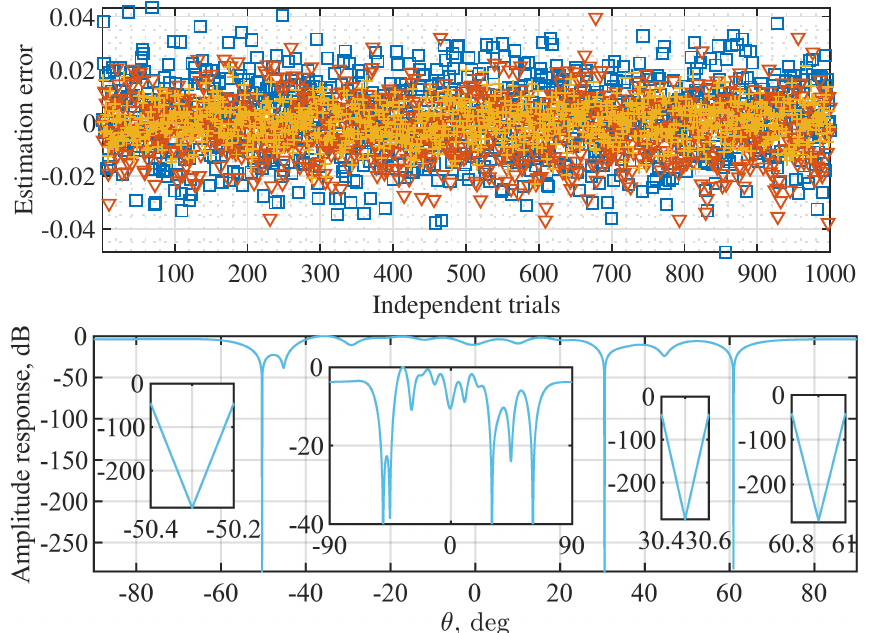
Figure 9. Illustration of the amplitude responses of AINB beams designed by Algorithm 1, where = 0, and the angles set in Figure 2 are used. The upper figure plots the N = 16, P = 3, K = 50, σ 2 i AoA estimation errors over 10 3 independent trials, where plus, triangle, and square markers are for 30.5 ◦ , 60.9 ◦ , and − 50.3 ◦ , respectively. Note that the second inset from the left in the lower sub-figure is the copy of Figure 9 with the y -axis limited to [ − 40, 0 ] dB. It is provided to highlight the spatial amplitude response in the region of non-interference directions.